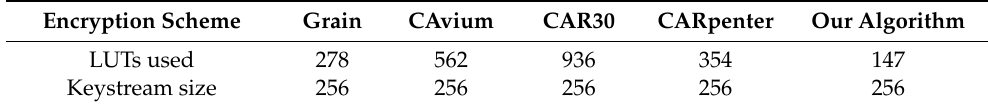
Table 6. Comparison with related stream